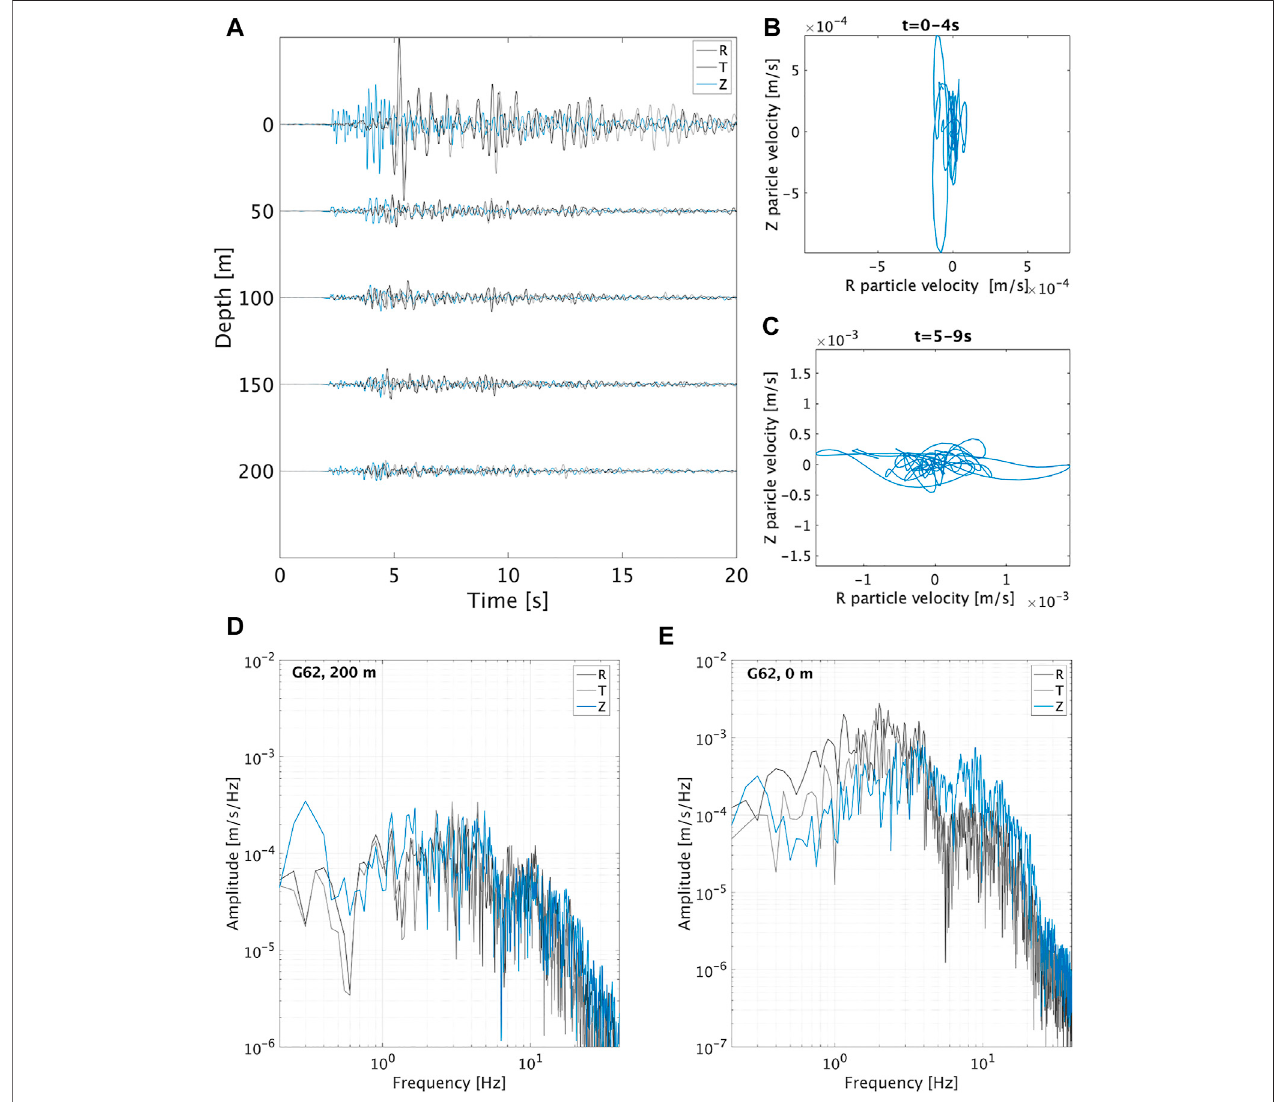
FIGURE4| EarthquakerecordinparticlevelocityforstationG62fortheZeerijpearthquakeonJanuary2018withmagnitude3.4fora20 swindowafterearthquake origin time. With in panel (A) 3-component borehole seismogram. (B) Particle motion in the R-Z plane for the direct P-wave arrival for a time window of 0 – 4 s for G62 surface seismometer. (C) Particle motion in the R-Z plane for the direct S-wave arrival for a time window of 5 – 9 s for G62 surface seismometer. (D) Fourier Amplitude Spectra of the 200 m seismometer. (E) Fourier Amplitude Spectra of the surface seismometer.